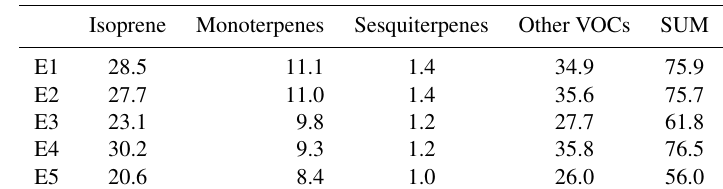
Table 5. The total annual BVOC emissions (Gg) from all experiments. Isoprene